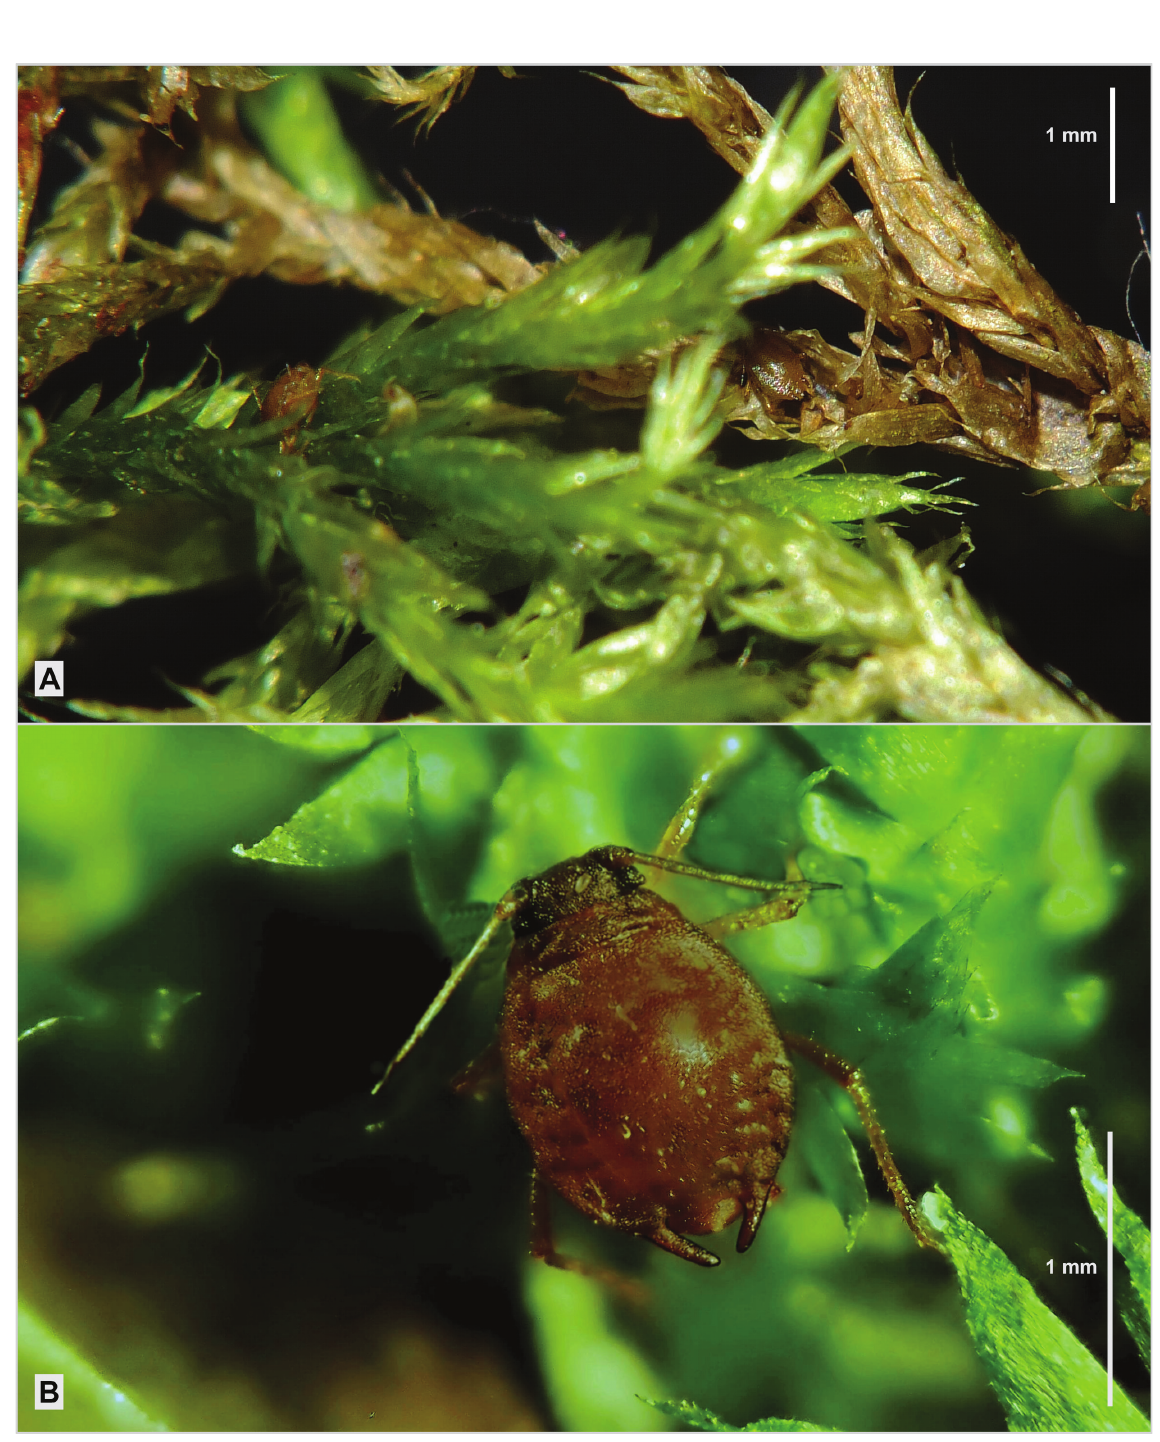
Fig. 13. Muscaphis escherichi (börner, 1939). A . Apt. on Cirriphyllum piliferum. B . Apt. on Sciuro- hypnum oedipodium